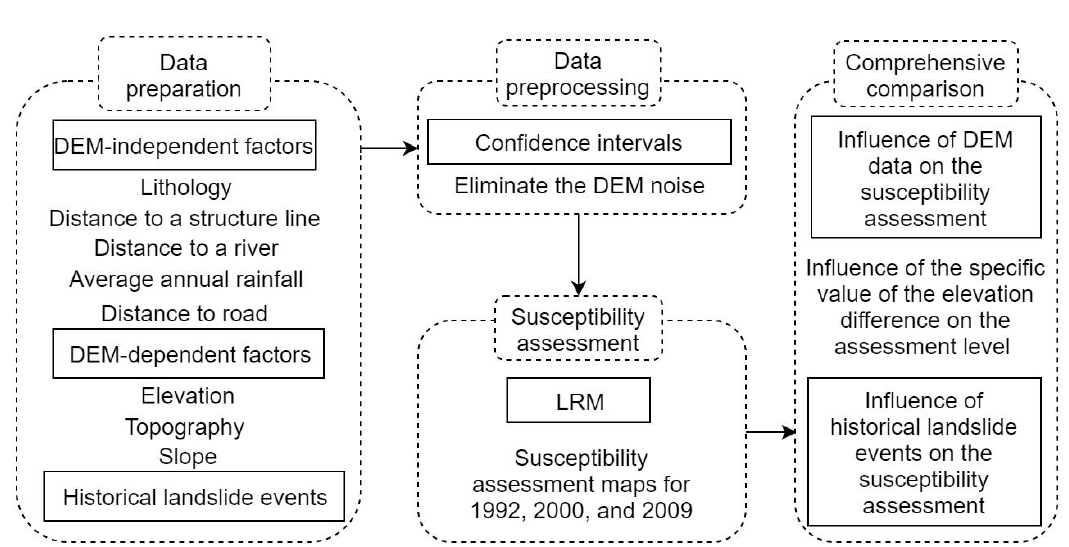
Figure 5. Zoning map of ( a ) lithology, ( b ) distance to a structure line, ( c ) distance to a river, ( d ) and average annual rainfall.